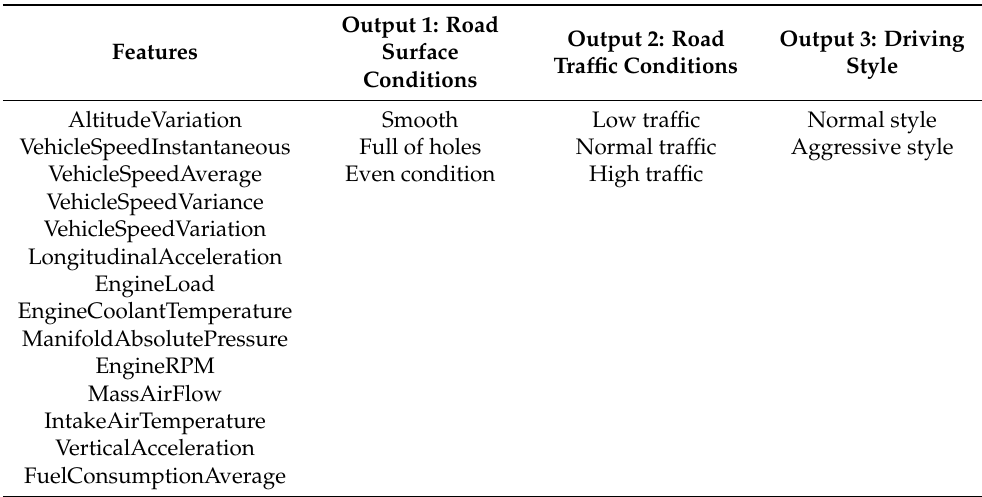
Table 1. The dataset input features and the output classes for the road conditions, traffic conditions and the driving style.